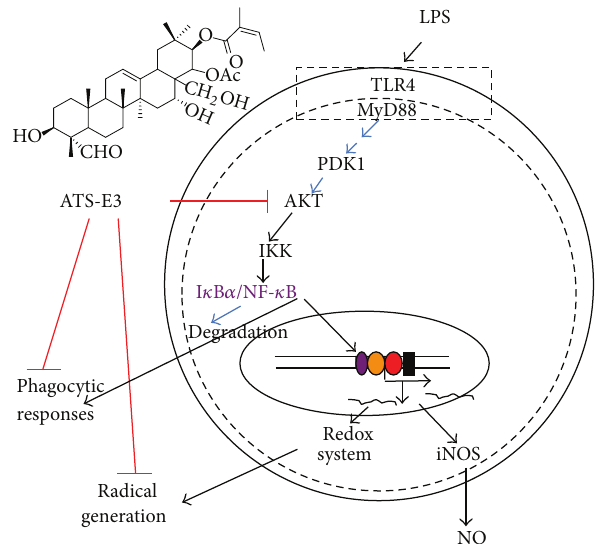
Figure 5: Putative inhibitory pathway of macrophage-mediated inflammatory responses by